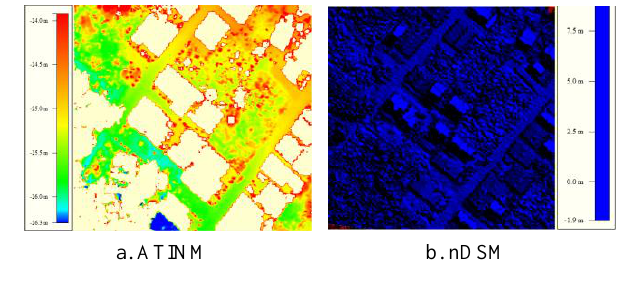
Figure 5.The result of a. ATINM, b. nDSM